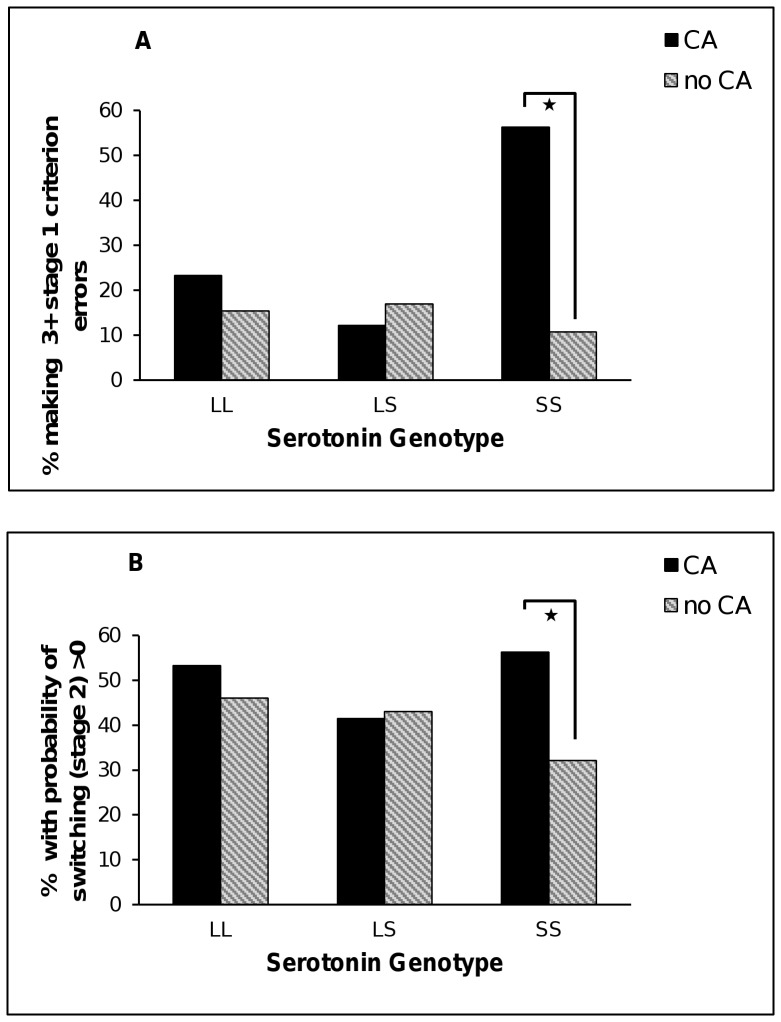
PRT results by gene variants in 5-HTTLPR and early childhood adversities (CA).Panel A shows the proportion of participants making 3+ errors to reach task criterion in stage 1 in response to negative feedback. Panel B shows the probability of switching in response to negative feedback in stage 2. * p<0.01.